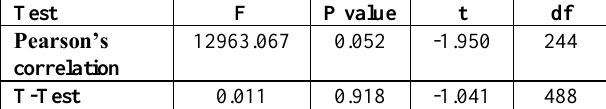
Table 3. Summary of statistical –Tree height from field and